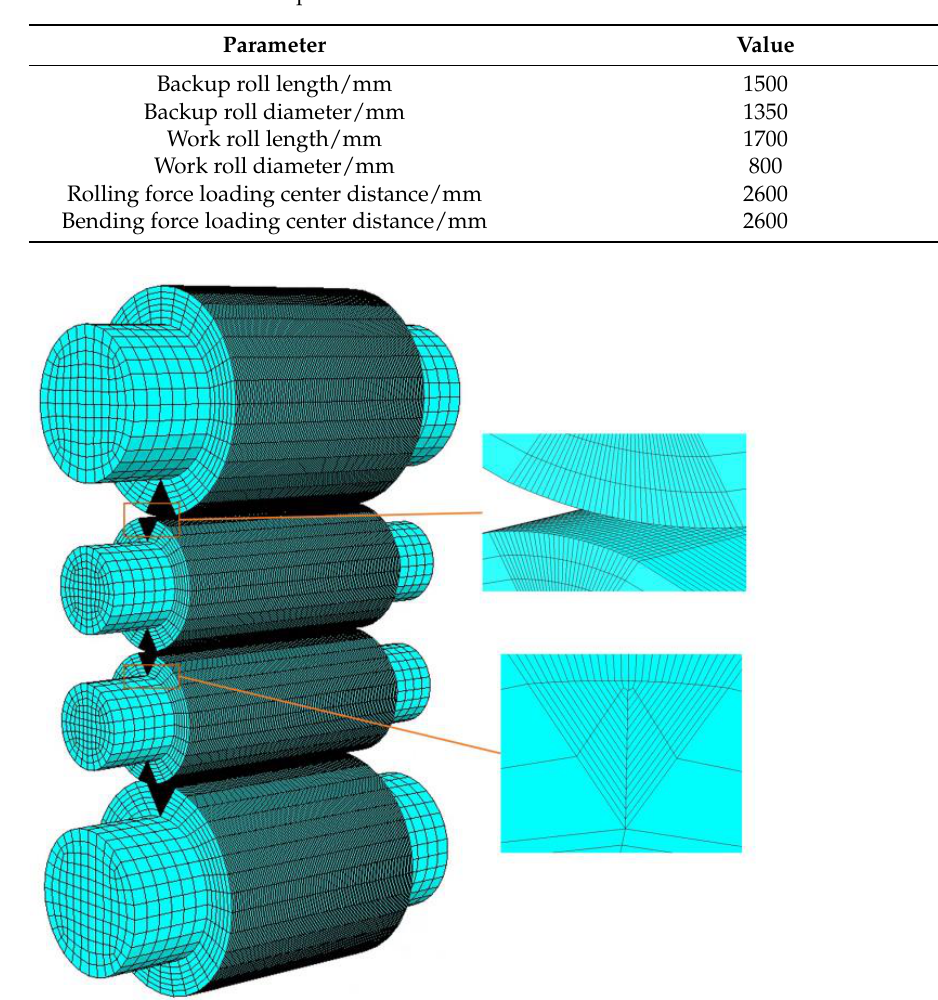
Table 1. Simulation model parameters.